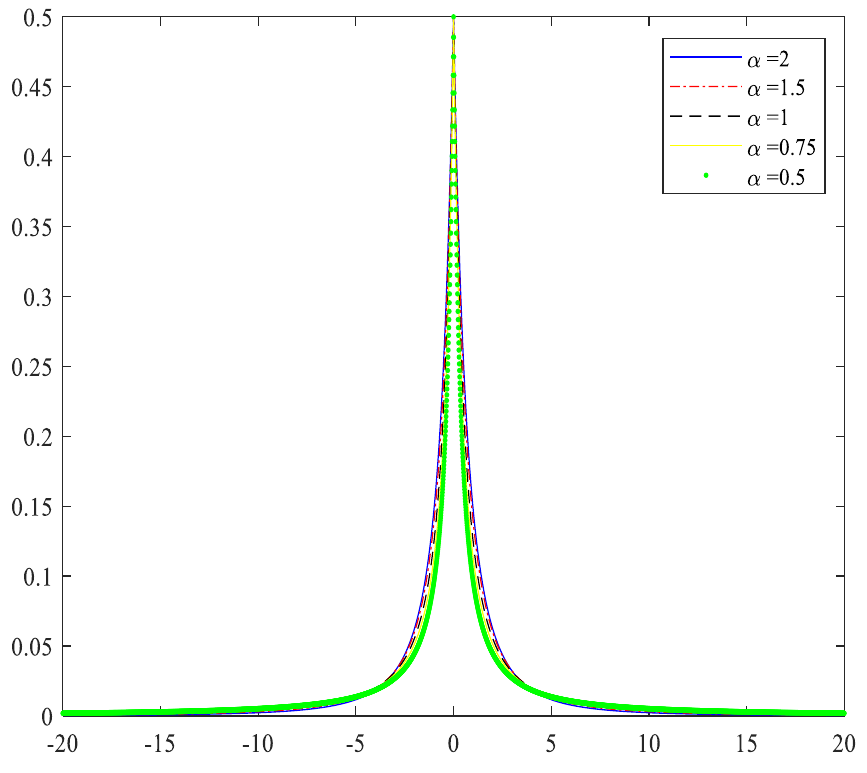
Figure 7. Comparison of α value in GPD PDF plots.